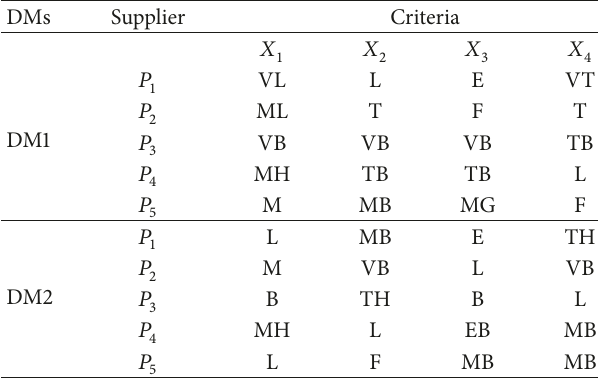
Table 5: The assessments of alternatives 𝐴 𝑖 .